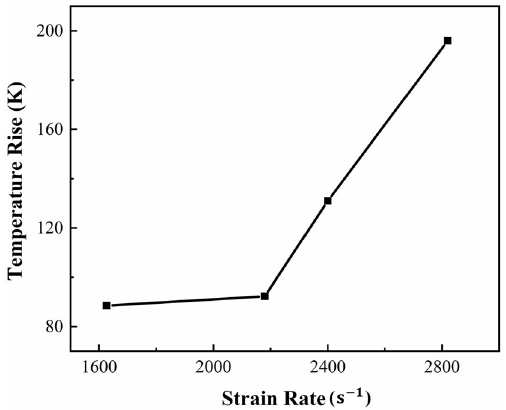
Figure 6. Temperature rises of the Ti−6Al−1Mo−2Zr−0.55Fe−0.1B alloy at different strain rates.